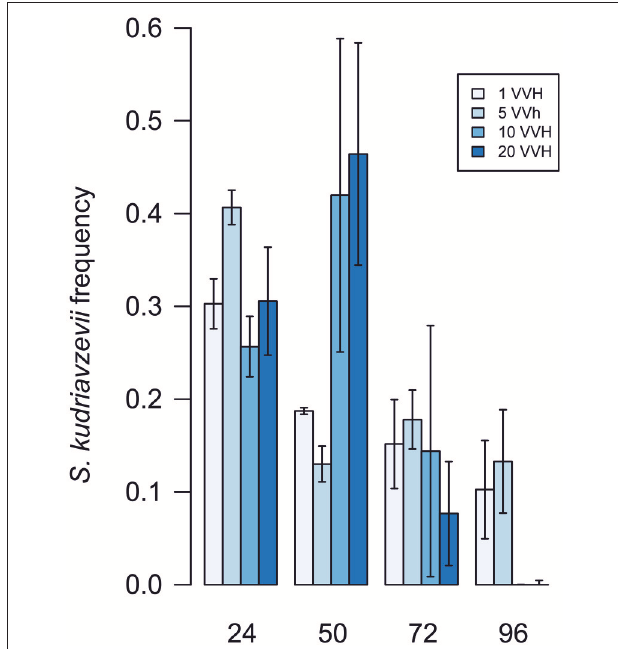
FIGURE 1 | S. kudriavzevii frequency under different aeration conditions. Values are mean of three replicates. Error lines represent standard deviations.